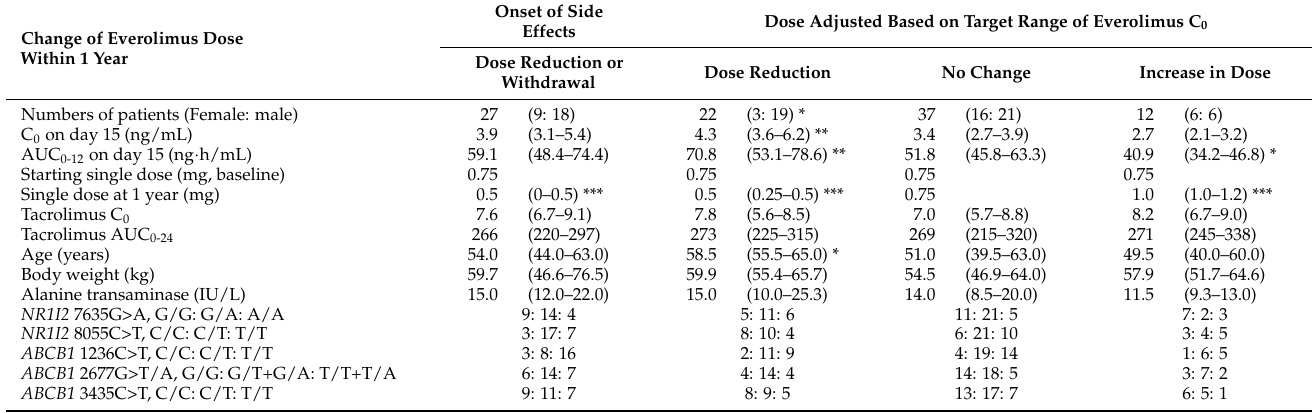
Table 5. Relationships between changes in everolimus dose within 1 year after beginning everolimus therapy and genotypes of NR1I2 and ABCB1